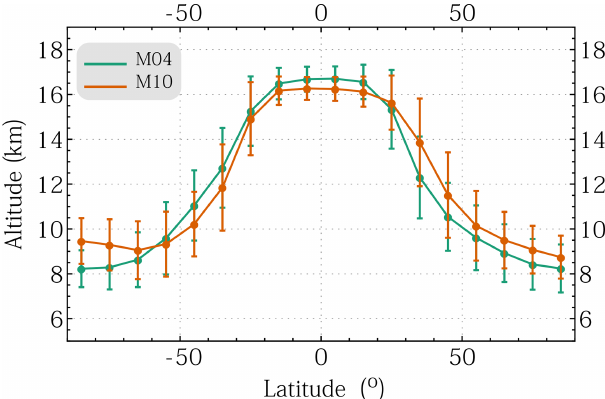
Figure 3. MERRA-2 daytime monthly zonal mean tropopause al- titude and its standard deviation as a function of latitude for April (M04) and October